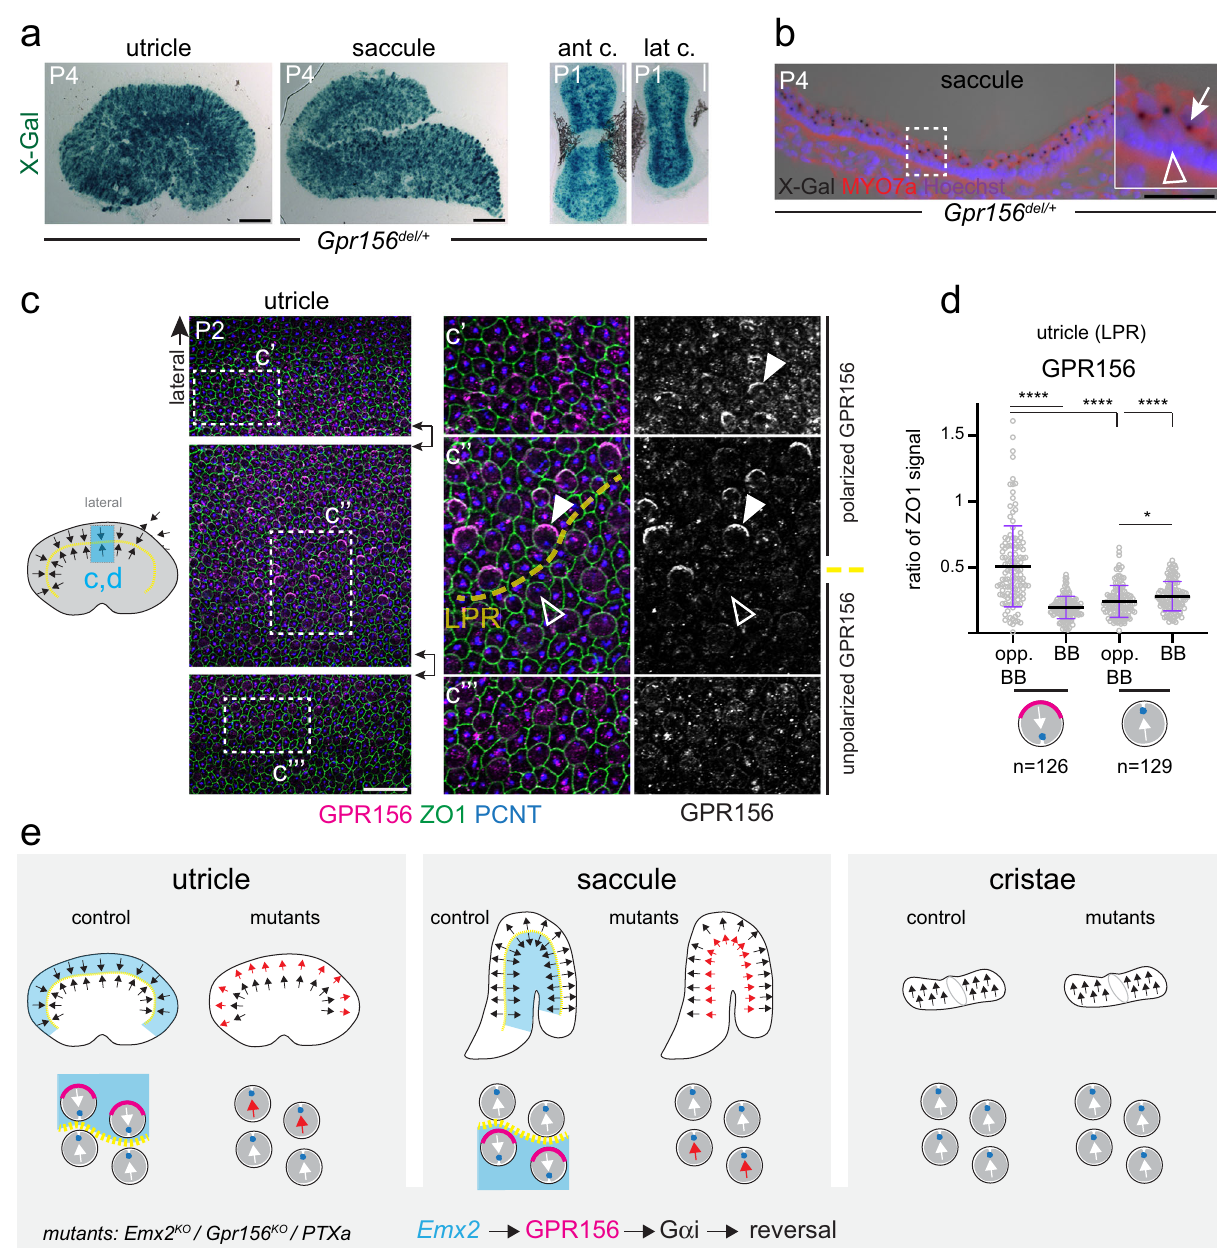
Fig. 2 Gpr156 expression and GPR156 protein localization in mouse vestibular organs. a LacZ reporter is expressed throughout the sensory region in Gpr156 del/ + vestibular organs (ant/lat c., anterior/lateral crista). b LacZ expression is limited to MYO7A + HCs in a saccule cross-section. X-gal signal is trapped in HC vesicles (arrow in magni fi ed inset) but support cells (arrowhead) are negative. c , d P2 wild-type utricle where basal body labeling (PCNT) indicates HC orientation. GPR156 polarization (solid arrowheads) is limited to lateral HCs oriented medially. HCs across the LPR oriented laterally do not show polarized GPR156 (hollow arrowheads). Boxed regions in continuous fi elds in the left panels are magni fi ed in the central and right panels (saccule: see Supplementary Fig. 2c). d GPR156 enrichment in the utricle LPR domain at the HC junction opposite (opp. BB) or near (BB) the basal body. HCs oriented medially (left) are analyzed separately from HC oriented laterally (right). GPR156 is expressed as ratio of ZO1 signal (mean ± SD; n , HC numbers in 3 animals; Kruskal-Wallis test with Dunn ’ s multiple comparisons, **** p < 0.0001; * p = 0.0332). e Summary of HC orientation (arrows), GPR156 protein distribution (magenta) and previously reported Emx2 expression (blue) by vestibular organ in normal and mutant conditions. The scheme in c indicates the position of the domain analyzed in c and d (blue). Scale bars are 100 µ m ( a ), 50 µ m ( b ), 20 µ m ( c